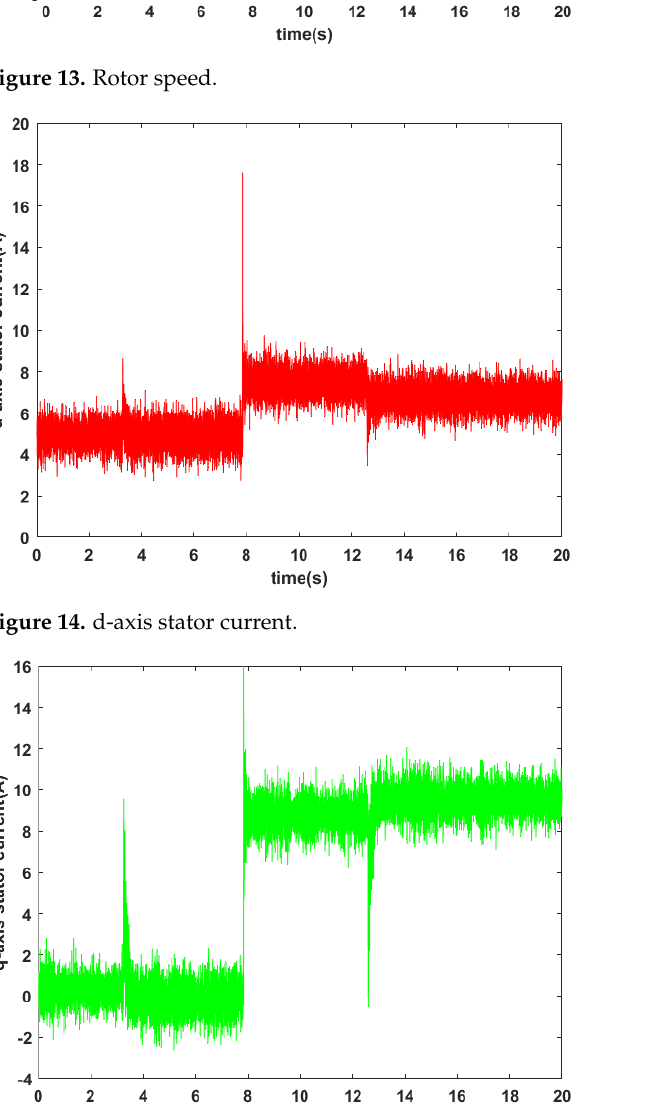
Figure 15. q-axis stator